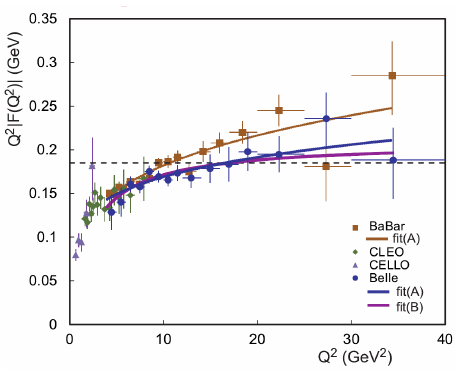
Figure 1: The γγ ∗ → π 0 transition form factor multiplied by Q 2 . The dashed line indicates the asymptotic behaviour of the form factor. Taken from [ 3 ]